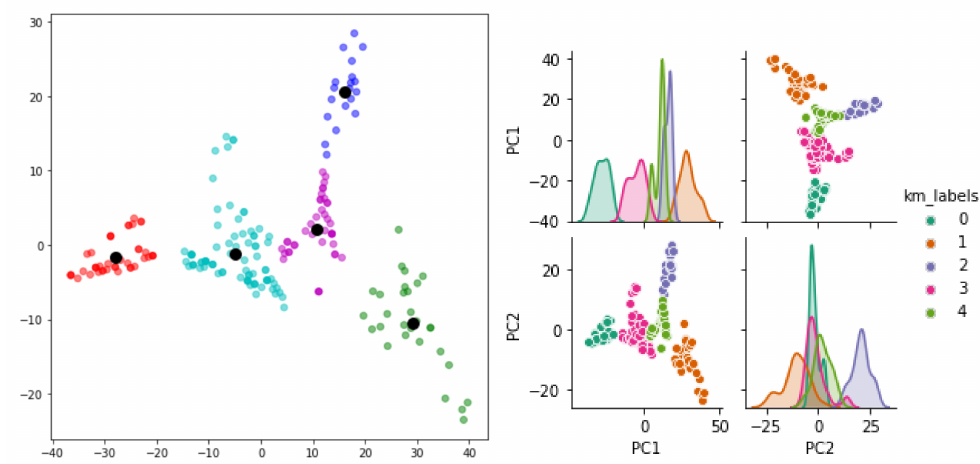
Figure 10. PCA and K-means clustering—flow rate data.